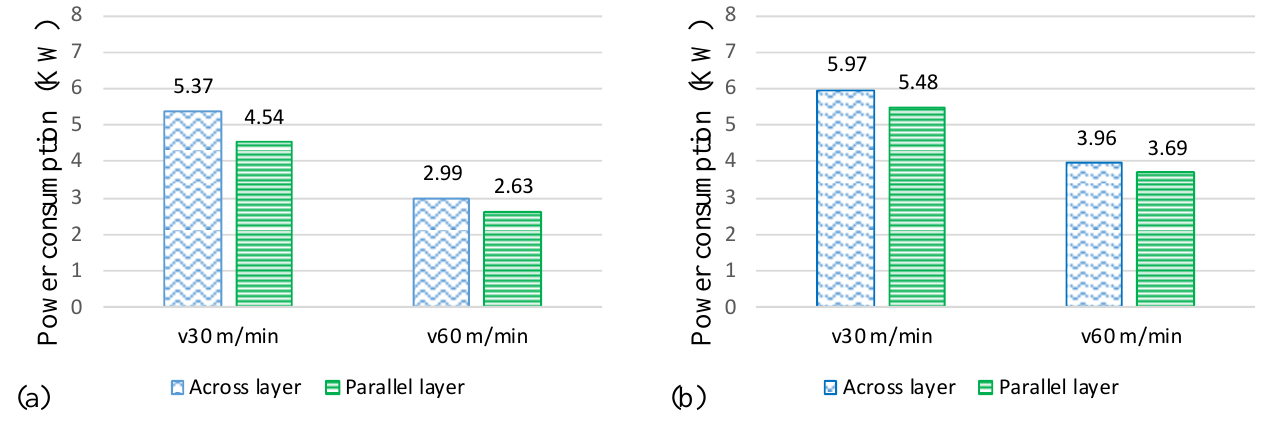
Figure 9. Power consumption recorded during the machining for AL and PL orientations at V = 30 and 60 m/min, and d = 0.2 mm at ( a ) f = 0.1 mm/rev and ( b ) f = 0.2 mm/rev.